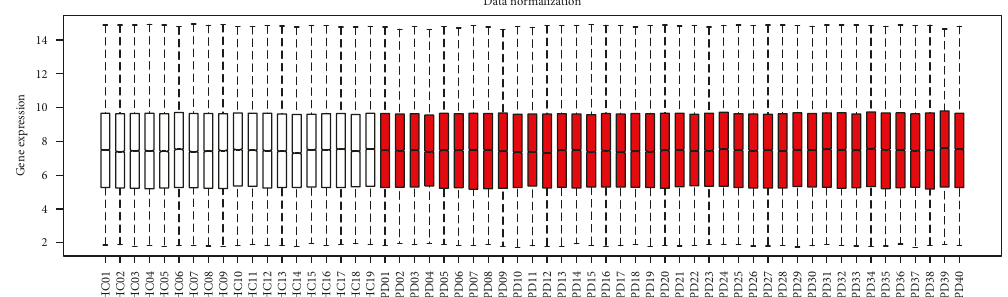
Figure 1: Boxplots for normalized gene expression data. Red represents the blood samples of patients with Parkinson’s disease, and white represents the healthy matched control samples.